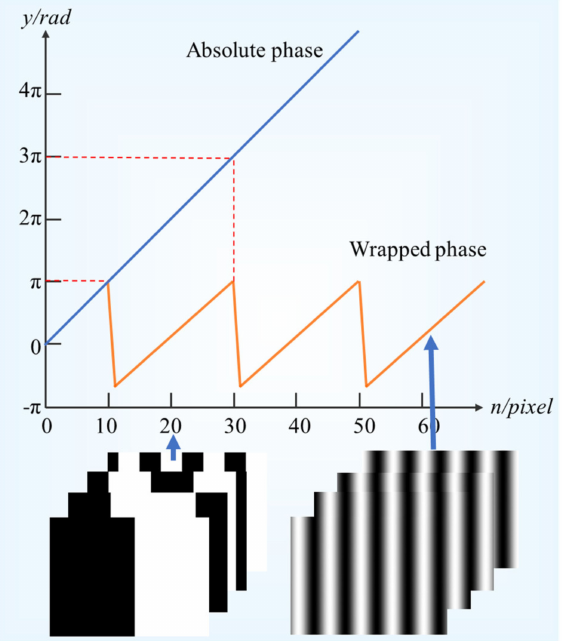
Figure 2. Decoding diagram of Gray code combined with phase − shift